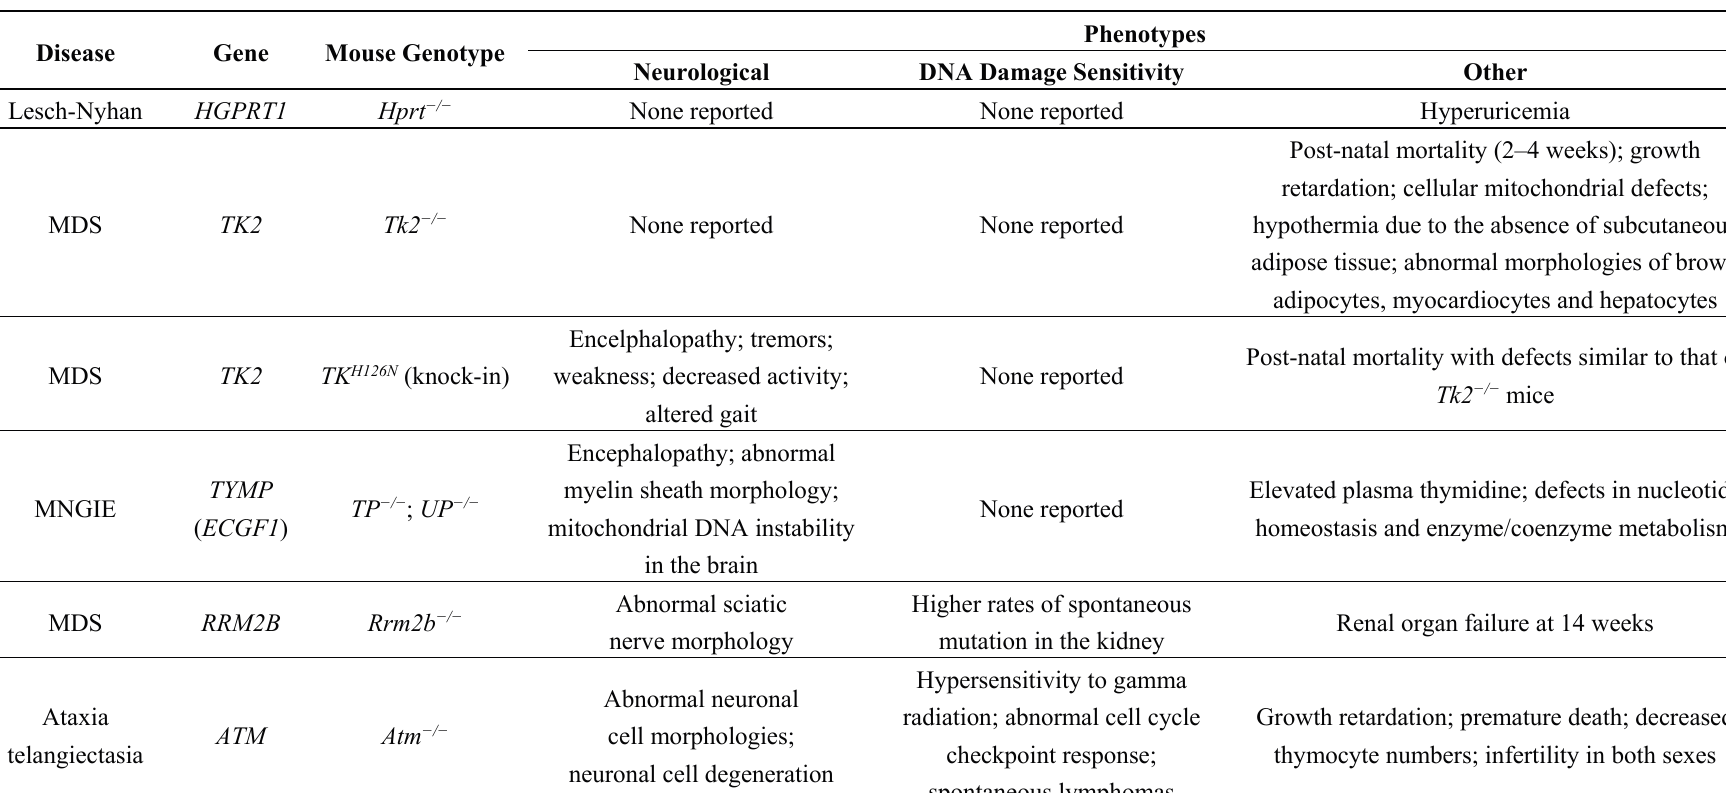
Table 2. Mouse models for human genetic defects in nucleotide salvage and